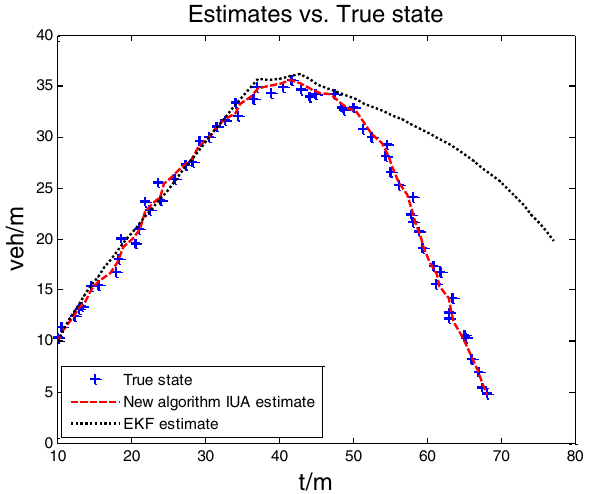
Figure 2. Comparison of estimation of IUA and EKF algorithms for traffic flow